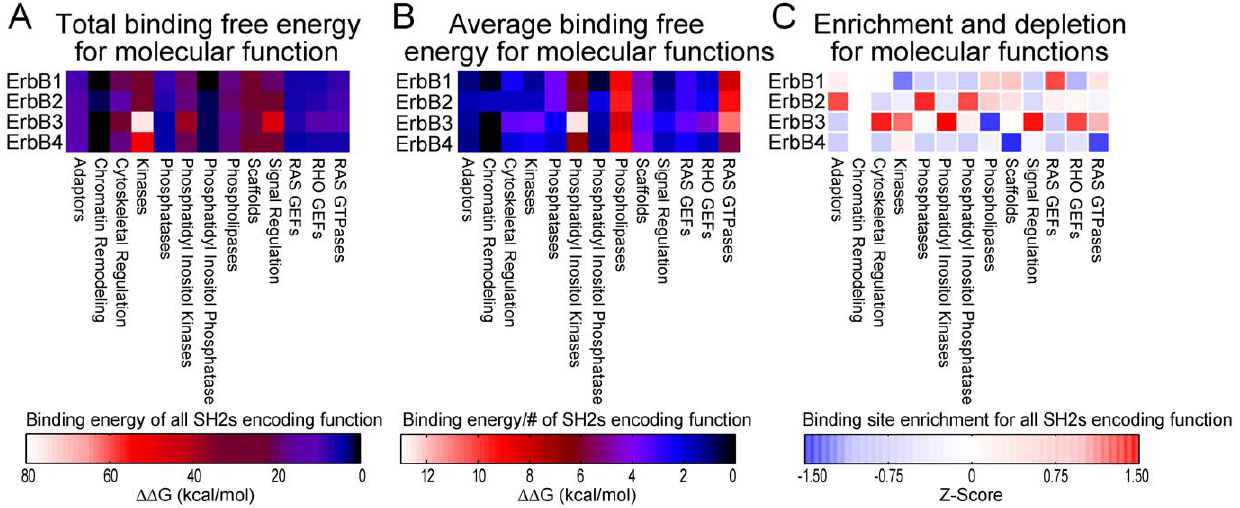
Figure 6. Comparison of the affinity with which each ErbB family member recruits proteins representing several molecular function categories. Relative binding free energies of interactions described in Figure 5C were summed across all domains contained in a particular functional category [55] in ( A ) (see Table S16) and divided by the number of SH2 domains represented in each class in ( B ) to determine an average recruitment potential for SH2s from each functional class. ( C ) ErbB receptor enrichment and depletion for binding sites for functional groups depicted by Z-score transformation of the raw data as in Figure 5D.